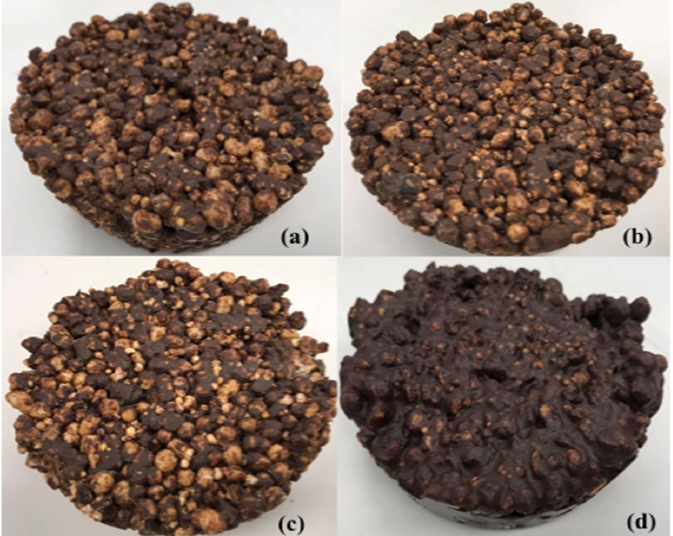
Figure 2. Samples of different energy snacks produced using different vegetable proteins mixtures. ( a ) PC, ( b ) PC65, ( c ) PB, and ( d ) control (without protein mixture).